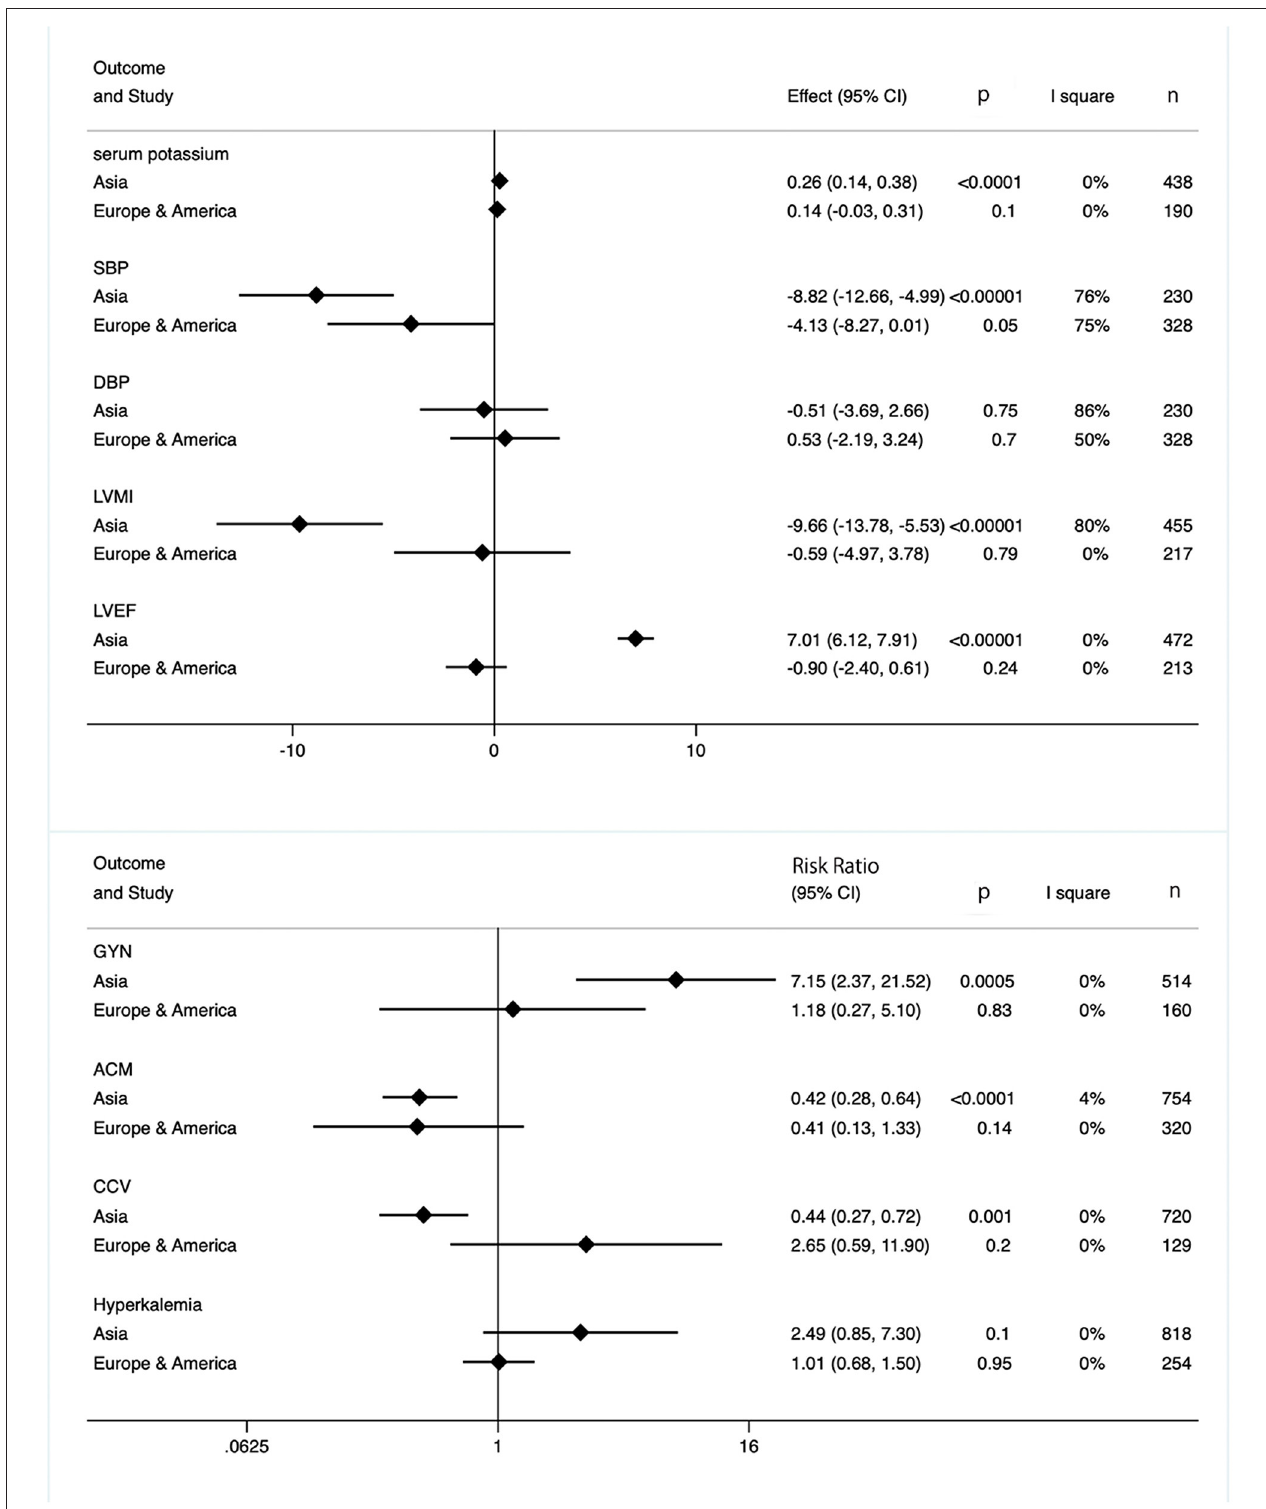
FIGURE 8 | Subgroup analysis based on